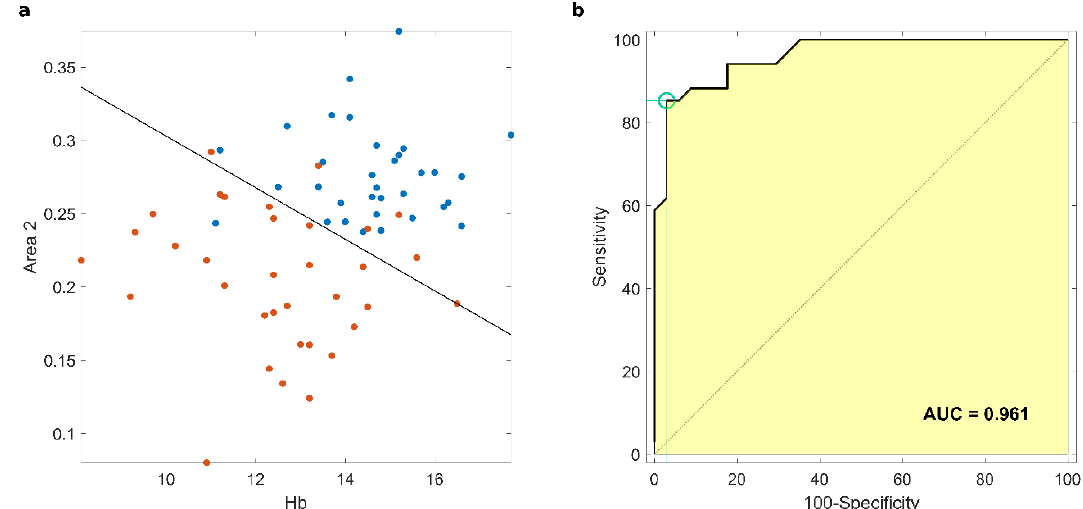
Figure 4. ( a ) Scatter plots for the best couple of PDAC predicting parameters, i.e., Area 2 and haemoglobin (Hb) concentration given in grams per deciliter. Each data point corresponds to a single sample (orange for PDAC, blue for non-oncological coronas), and solid black line depicts the output of the linear discriminant analysis for the two multivariate distributions. ( b ) AUC obtained by coupling Area 2 and Hb as classifiers.